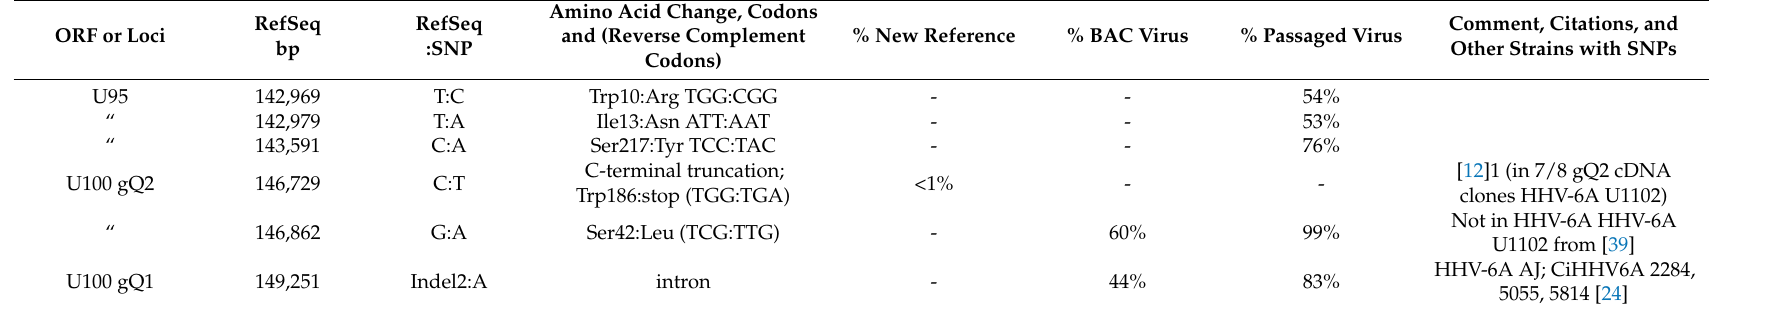
Indel2: AGGGGGGGG. Repetitive regions are shaded, DR repeats listed once here. * Adjacent to fusion loop 2 of Domain I (DI) homologue of human cytomegalovirus (HCMV) gB C246 [40], see text. (“) indicates same as above. (–) indicates no change in comparison to the reference genome